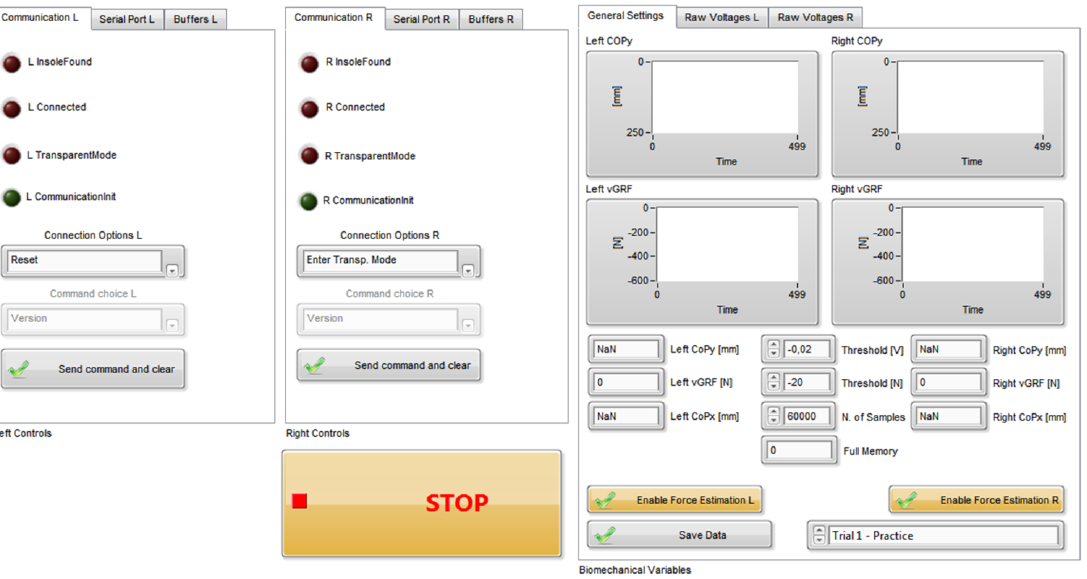
Figure 5. Graphical user interface developed in Labview